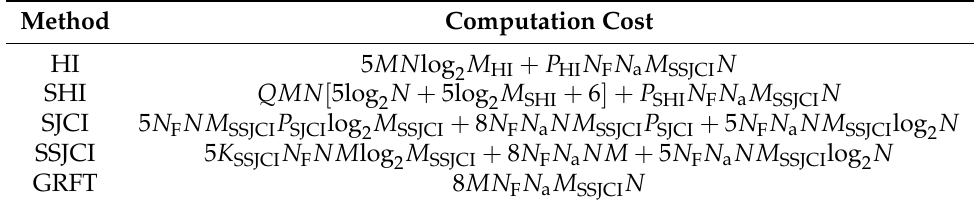
Table 3. Computation costs comparison.